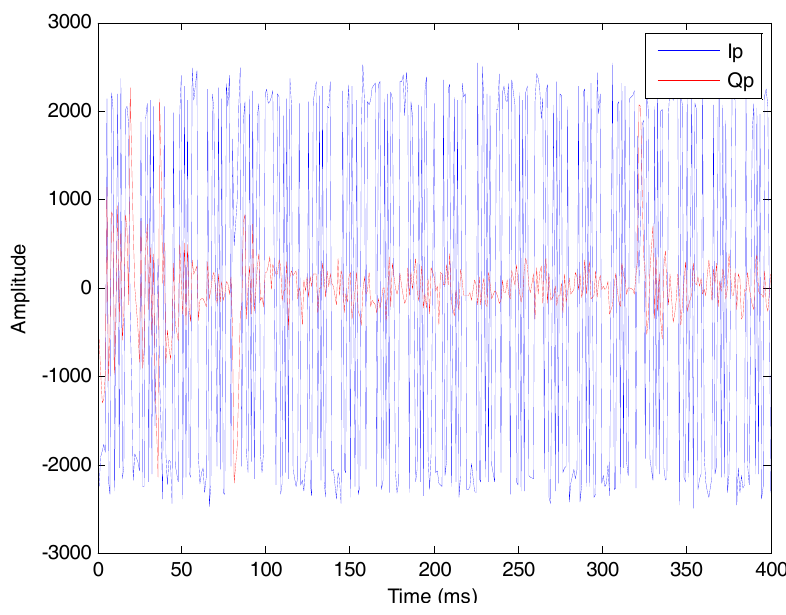
Figure 15. The tracking result of satellite #9.